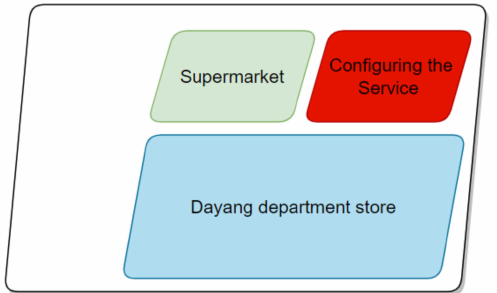
Figure 6. Layout of the underground floor of the Zhixin Cheng of Hefei City.